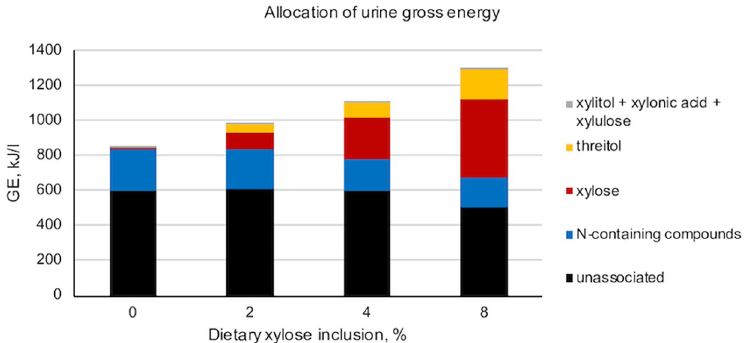
Fig 3. Allocation of urine gross energy (GE) from xylose, metabolites, and nitrogen (N)-containing compounds. Pigs (n = 12/treatment) were fed diets containing either 0, 2, 4, or 8% D-xylose. The presented values are treatment averages across 3 different collection periods. The effect of treatment was significant for all variables ( P � 0.042). Dietary xylose concentration linearly impacted each variable (linear contrast P � 0.012) except the unassociated fraction. Increasing dietary xylose concentration increased the urine GE (kJ/l) contributed from xylose (SEM = 17.4), threitol (SEM = 8.6), and the combination of all lesser metabolites (xylitol, xylonic acid, and xylulose; SEM = 0.3), but decreased the GE contributed from N-containing compounds (SEM = 17.0). The amount of urine GE unexplained by the xylose, its metabolites, or N-containing compounds (SEM = 45.3) was not different among the 0, 2, and 4% treatments ( P � 0.416) but was lower in the 8% treatment ( P = 0.042).